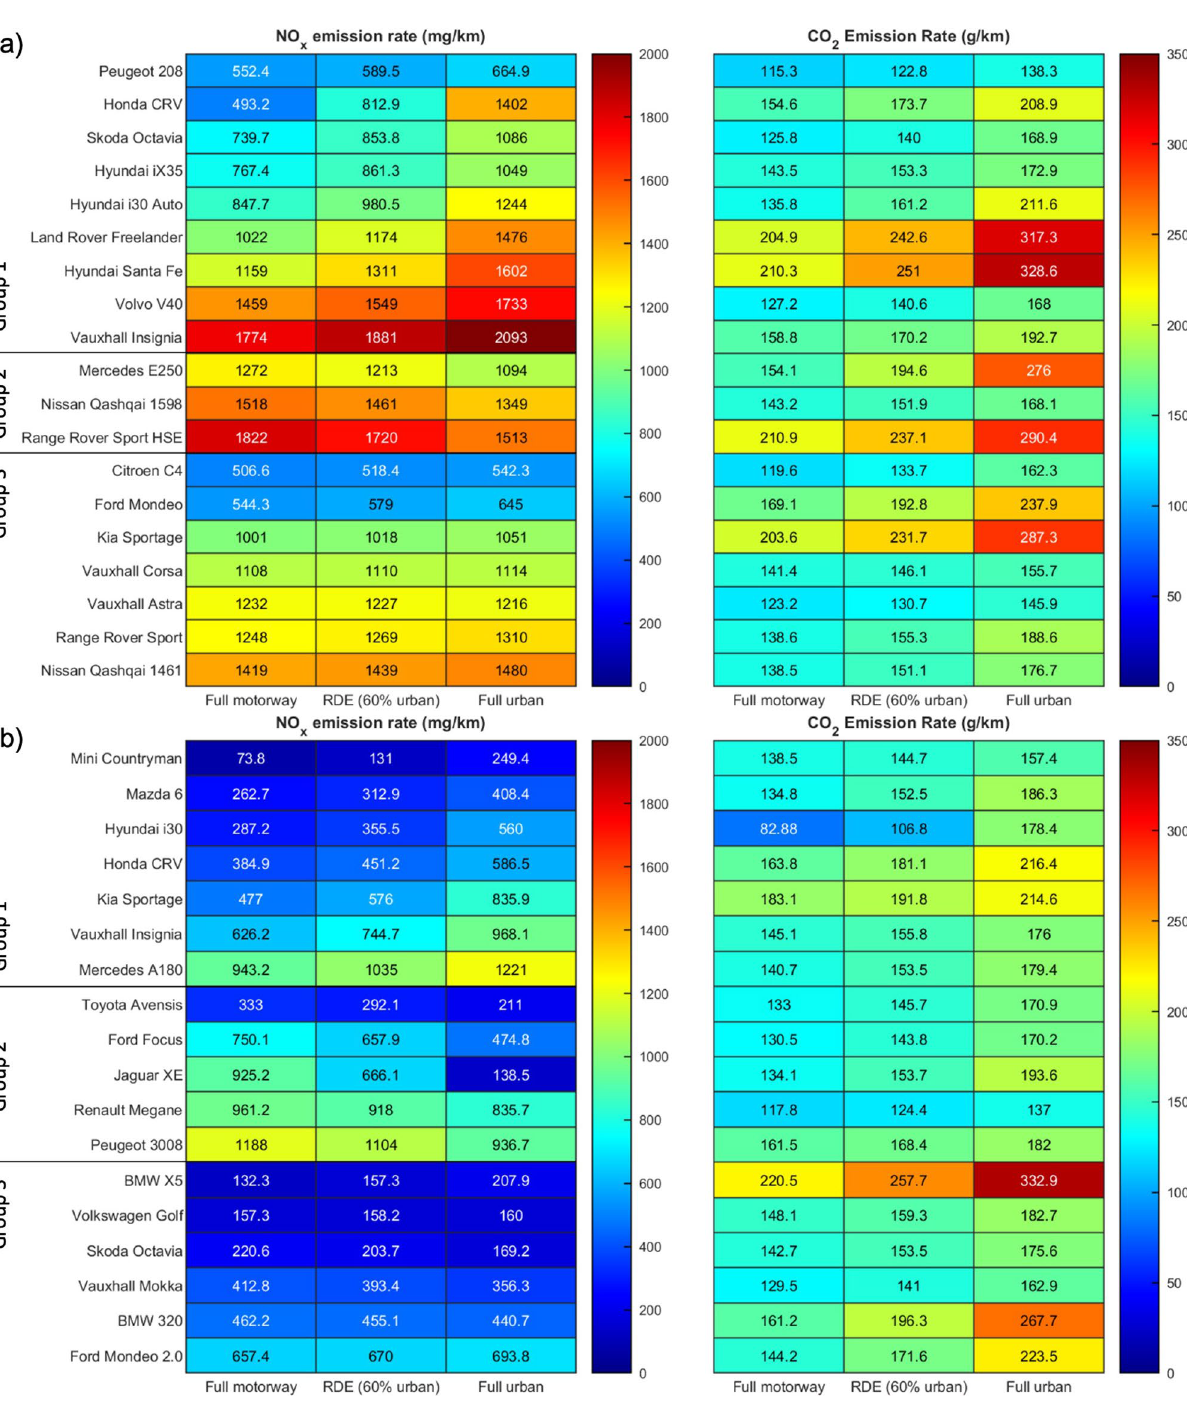
Figure 3. NO x and CO 2 emission rates of the tested vehicles based on the RLE methodology, with emission values presented in full urban, RDE (60% urban) and full motorway driving compositions. ( a , b ) Euro 5 vehicles ( a ), Euro 6 vehicles ( b ). Emission rates are represented by a heat map, with dark blue representing zero emissions and dark red representing the highest emission rate. For NO x , the vehicles are further arranged into 3 groups: Group 1—Increasing NO x emissions with greater urban driving, Group 2—Decreasing NO x emissions with greater urban driving, Group 3—NO x emissions being independent of drive cycle composition. Plots for the NO x and CO 2 full emissions spectrums across varying time proportions are available in Supplementary